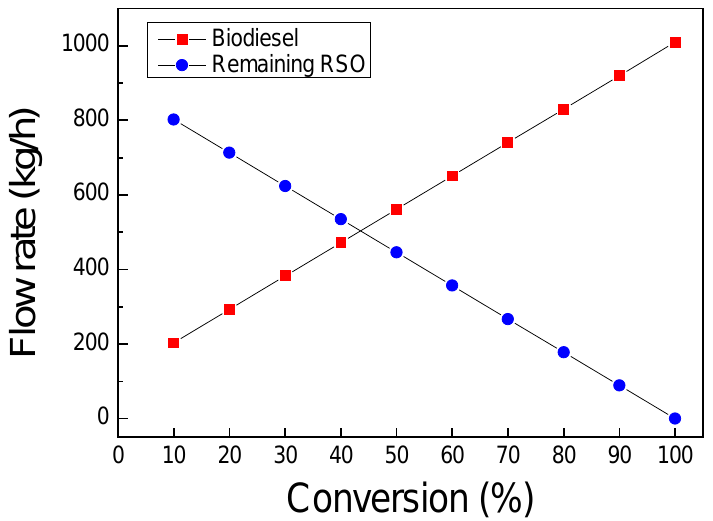
Figure 4. Mass flowrate of biodiesel product and remaining RSO in the product stream with different conversion assumptions.